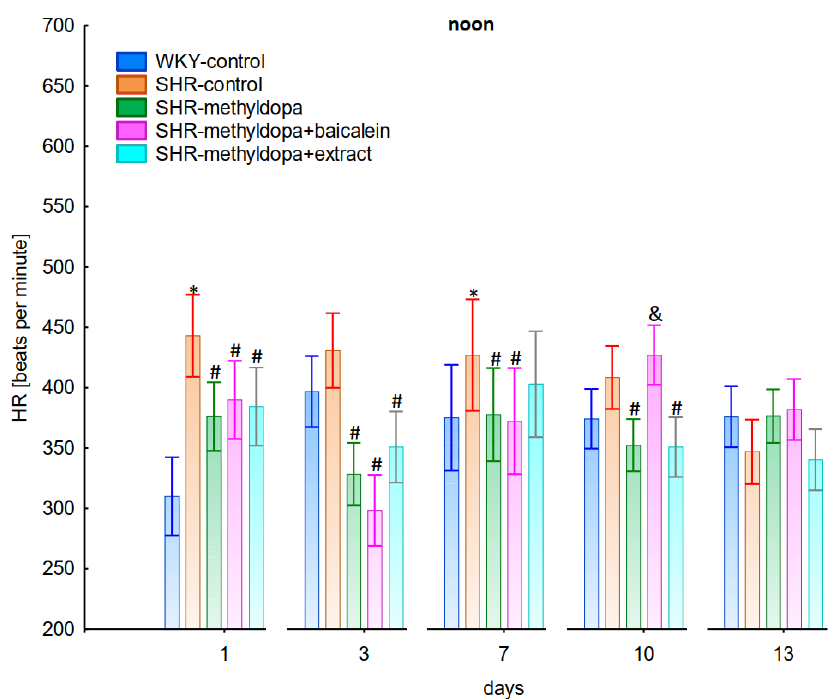
Figure 6. Influence of methyldopa and its combination with baicalein or extract from Scutellaria baicalensis roots on noon heart rate (HR) in SHR pregnant rats. Legend: n = 10, mean ± SEM; *—vs. WKY control, p < 0.05; #—vs. SHR control, p < 0.05; &—vs. SHR-methyldopa, p < 0.05. Administration of methyldopa significantly ( p < 0.05) reduced SBP in SHR animals at all time points, with the strongest decrease on day 3, whereas during DBP and HR meas- urements the drug significantly ( p < 0.05) reduced the parameters in SHR animals on days 3, 10, and 13 (for DBP) and on days 1, 3, 7, and 10 (for HR). Baicalein administered together with methyldopa significantly ( p < 0.05) decreased SBP and DBP in relation to animals receiving methyldopa alone on days 1, 3, and 7. During HR measurements such effects were observed on days 3 and 10 only. S. baicalensis root extract administered together with methyldopa significantly ( p < 0.05) lowered SBP and DBP values in relation to methyldopa on days 1, 7, 10, and 13, but during HR measurements the combined effect of S. baicalensis root extract and methyldopa was similar in potency to the drug alone. 2.2.3. Evening Values of SBP, DBP, and HR In the studies on the influences of the tested compounds on the SBP, DBP, and HR measured in the evening, statistically significant overall variability was observed (for SBP (ANOVA II — total effect: F(4, 47) = 112.2, p < 0.0001; time effect: F(12, 564) = 71.4, p < 0.0001; and interaction: F(48, 564) = 13.9, p < 0.0001), for DBP (ANOVA II — total effect: F(4, 47) = 39.7, p < 0.0001; time effect: F(12, 564) = 21.3, p < 0.0001; and interaction: F(48, 564) = 7.34, p < 0.0001) and for HR (ANOVA II — total effect: F(4, 47) = 13.2, p < 0.0001; time effect: F(12, 564) = 11.3, p < 0.0001; and interaction: F(48, 564) = 5.16, p < 0.0001)). During the entire experiment, the SHR control rats had significantly higher SBP, DBP, and HR than the WKY control rats ( p < 0.05), and the values practically did not change in the following days of the experiment (Figures 7 – 9).